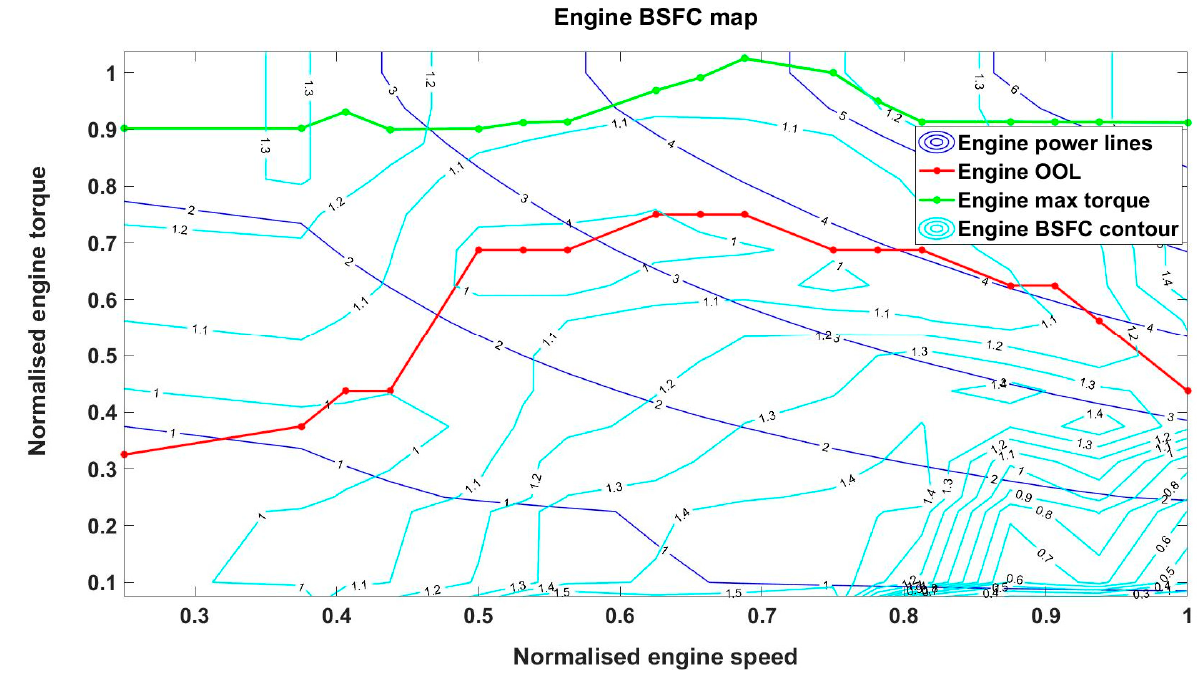
Figure 2. Normalised engine BSFC map.